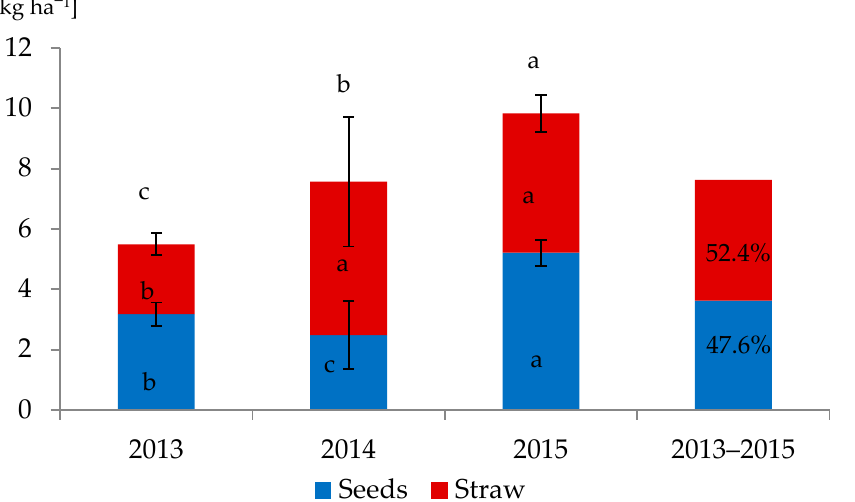
Figure 7. Magnesium accumulation (kg ha − 1 ) in whole faba bean plant (average for years). The vertical line atop bar is SD for that mean. Different letters indicate a significant difference (Tukey’s multiple range test).